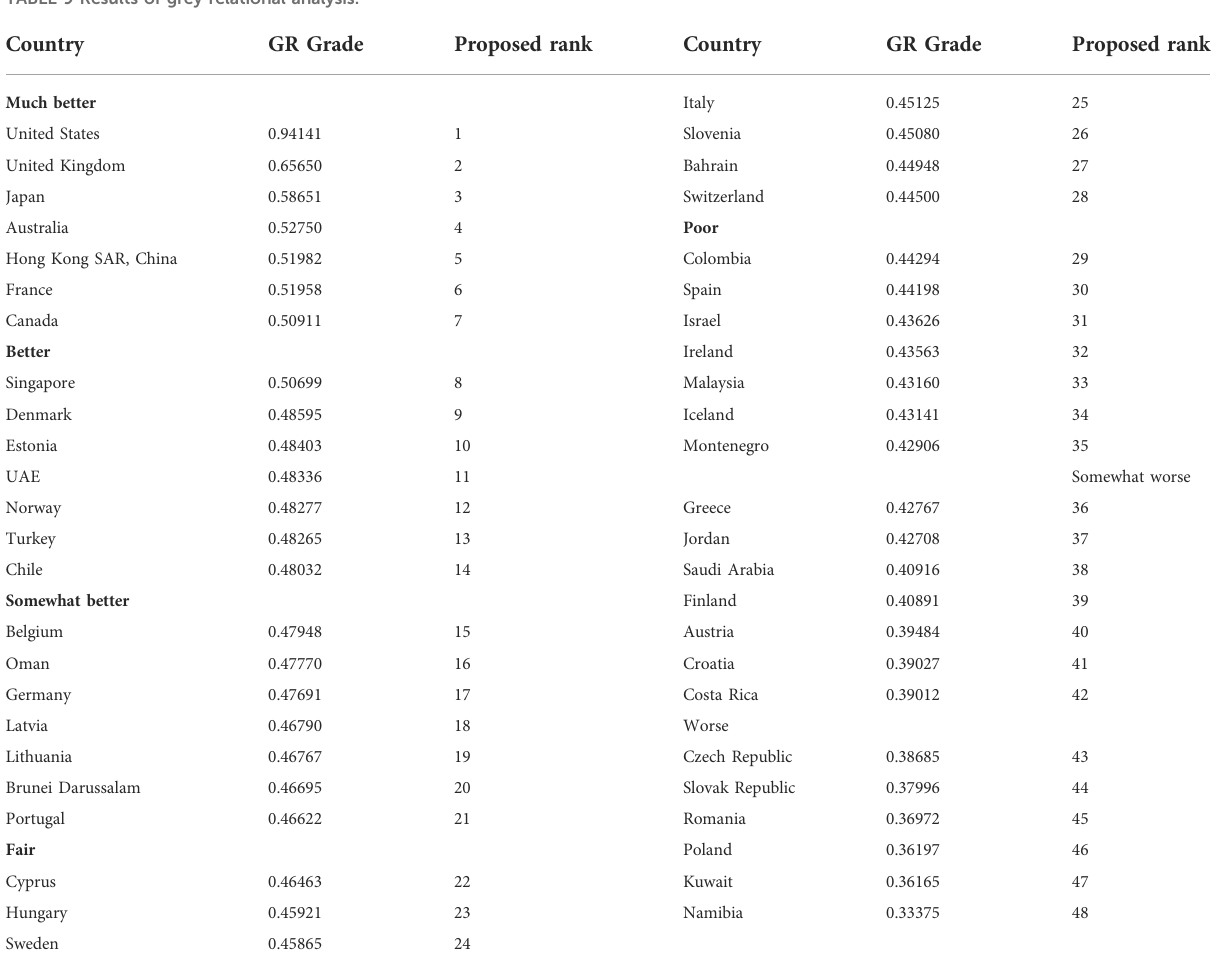
TABLE 9 Results of grey relational